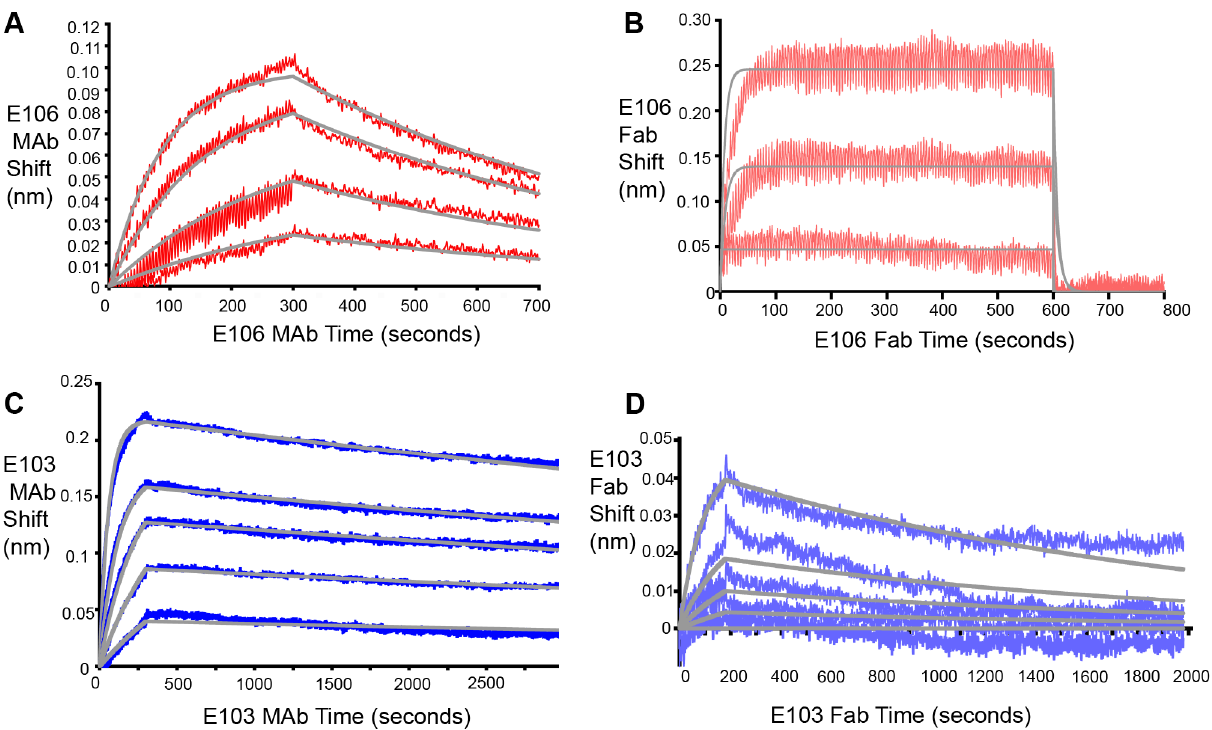
Figure 4. Fab and MAb binding to DENV-1 RVPs. ( A ) E106 MAb binding to DENV-1 RVPs by bio-layer interferometry. E106 MAb binds with high apparent affinity to DENV-1 RVPs (K Dapp of 13 6 2 nM) with a slow dissociation (t 1/2 . 400 sec). Raw data is in red and fits are in gray. ( B ) Direct binding of E106 Fab to DENV-1 RVPs. Results are representative of several independent experiments that showed low affinity binding (K D of . 1 m M) and fast off-rate kinetics (t 1/2 , 2 sec). Raw data is in salmon and fits are in gray. BLI determined binding of the control E103 ( C ) MAb and ( D ) Fab to DENV-1 RVPs. E103 MAb and Fab binding to DENV-1 RVPs are comparable, with a calculated apparent K Dapp of 0.8 6 0.1 nM and K D of 7 6 1 nM, respectively, as expected for a predominantly monovalent interaction. Raw data is in blue (E103 MAb) and purple (E103 Fab) and fits are in gray. Results are representative of at least two independent experiments. doi:10.1371/journal.ppat.1004072.g004 separating the docked Fab CH1 domain C-termini with the possibility for limited bivalent bridging, with the primary expectation that distances greater than 50 A˚ would be unlikely candidates being adjacent outer 5-fold epitopes (49 A˚ CH1 spanned by 16 hinge residues [36,37]. This analysis indicated the separation) ( Fig. 6B and D ) as well as adjacent inner and outer